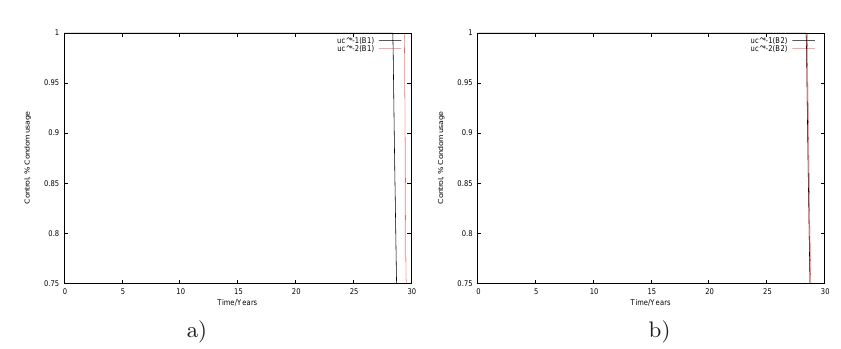
Figure 2. Graphs of the numerical solutions to the behaviour of the control constrain u ∗ c , (a) when B 1(1) = 0 . 025 and B 1(2) = 2 . 5 , and (b) when B 2(1) = 0 . 025 and B 2(2) = 25 . 0 . With initial conditions similar to conditions in Figure